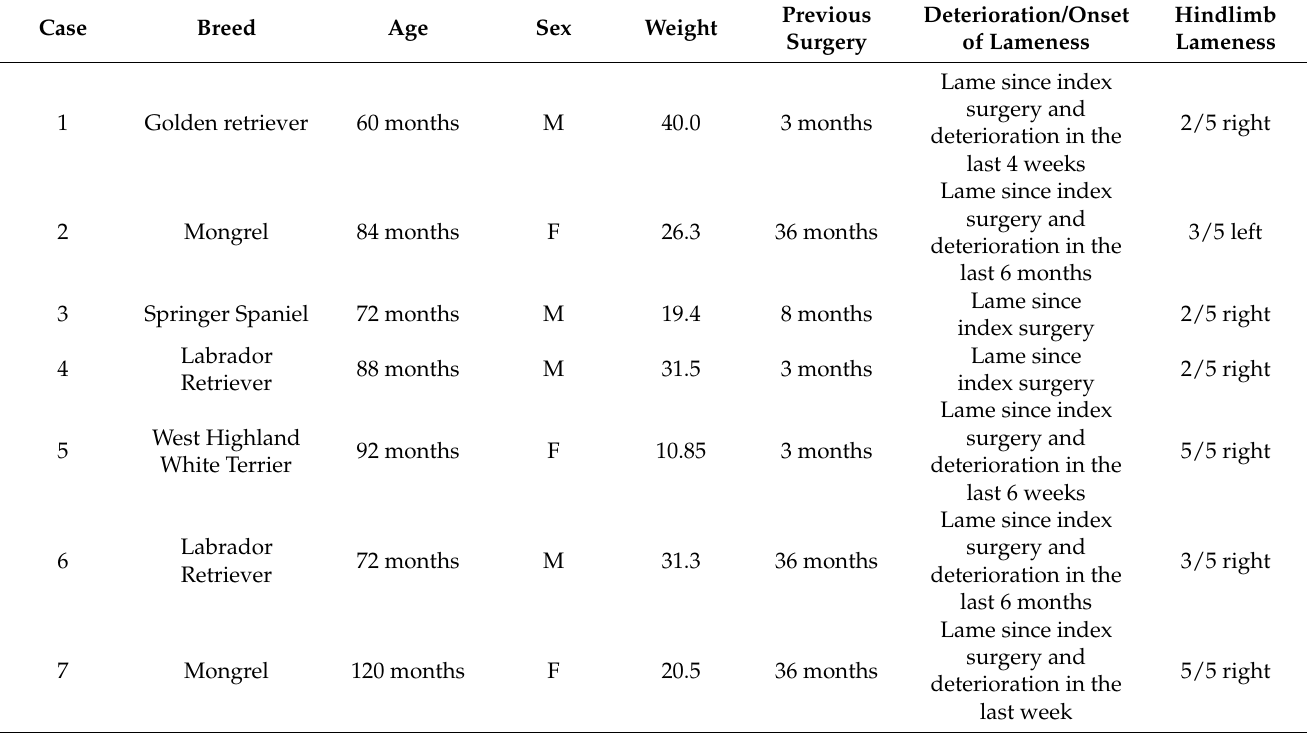
Table 1. Clinical data.